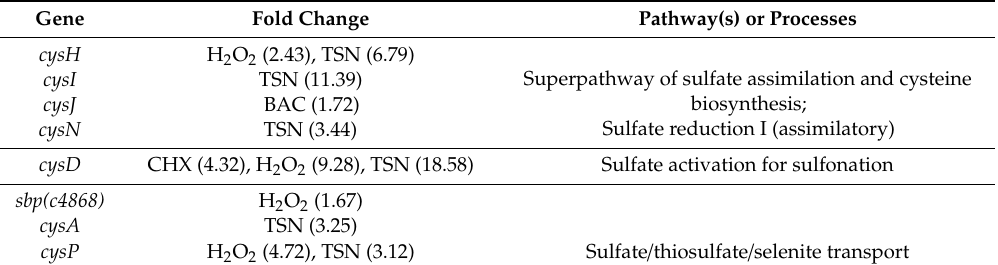
Table 5. Fold changes of genes involved in pathways transporting or utilizing sulfur in response